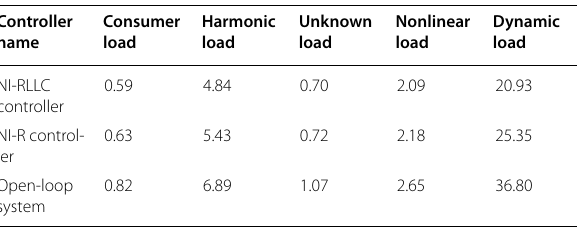
Table 7 Total harmonic distortion (THD) for different loads of SISO system